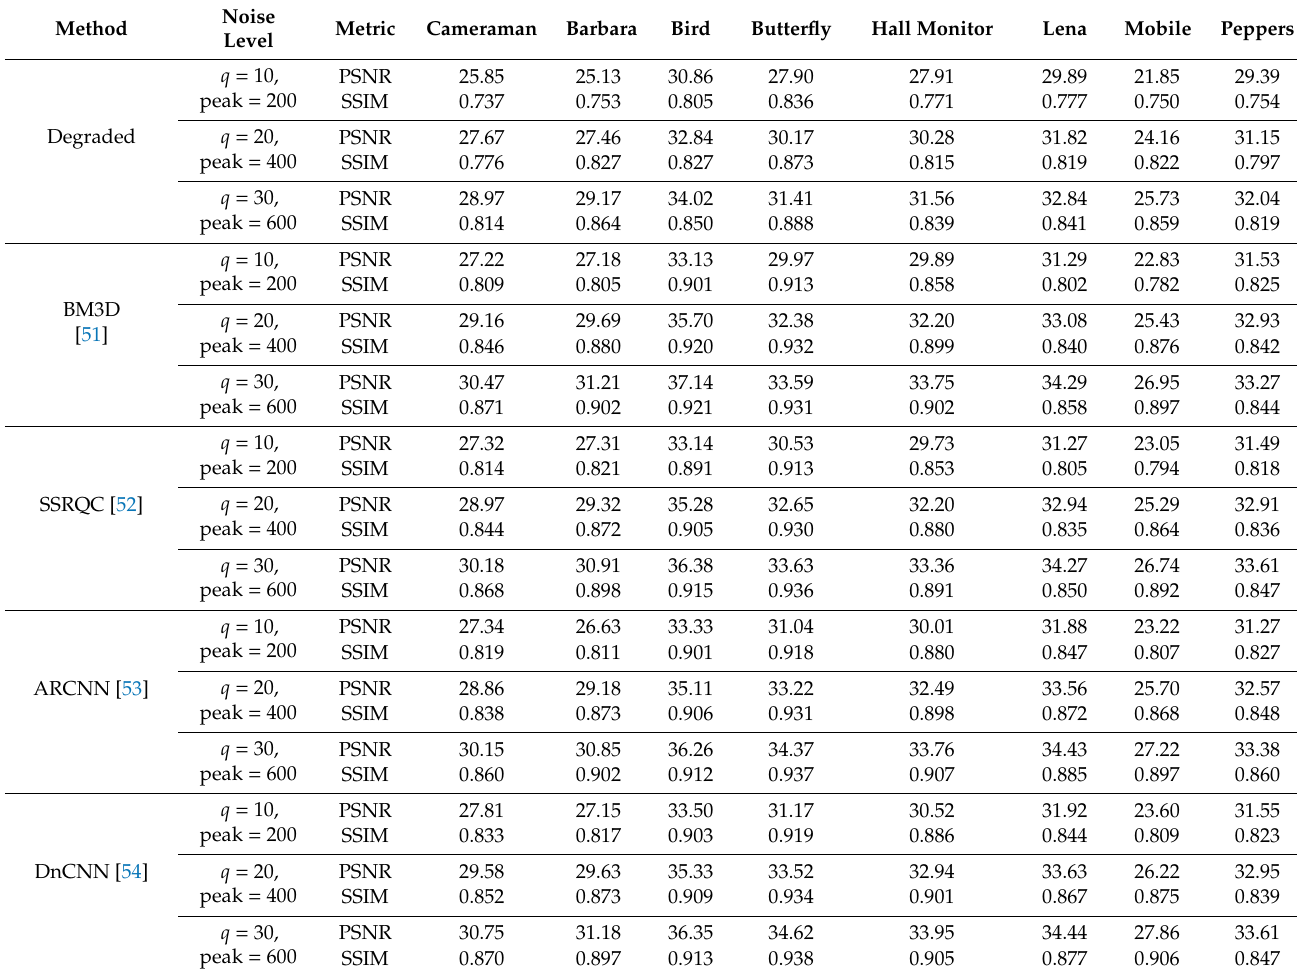
Table 1. Comparison of the quantitative denoising quality of eight conventional images in terms of peak signal-to-noise ratio (PSNR) (dB) and structure similarity